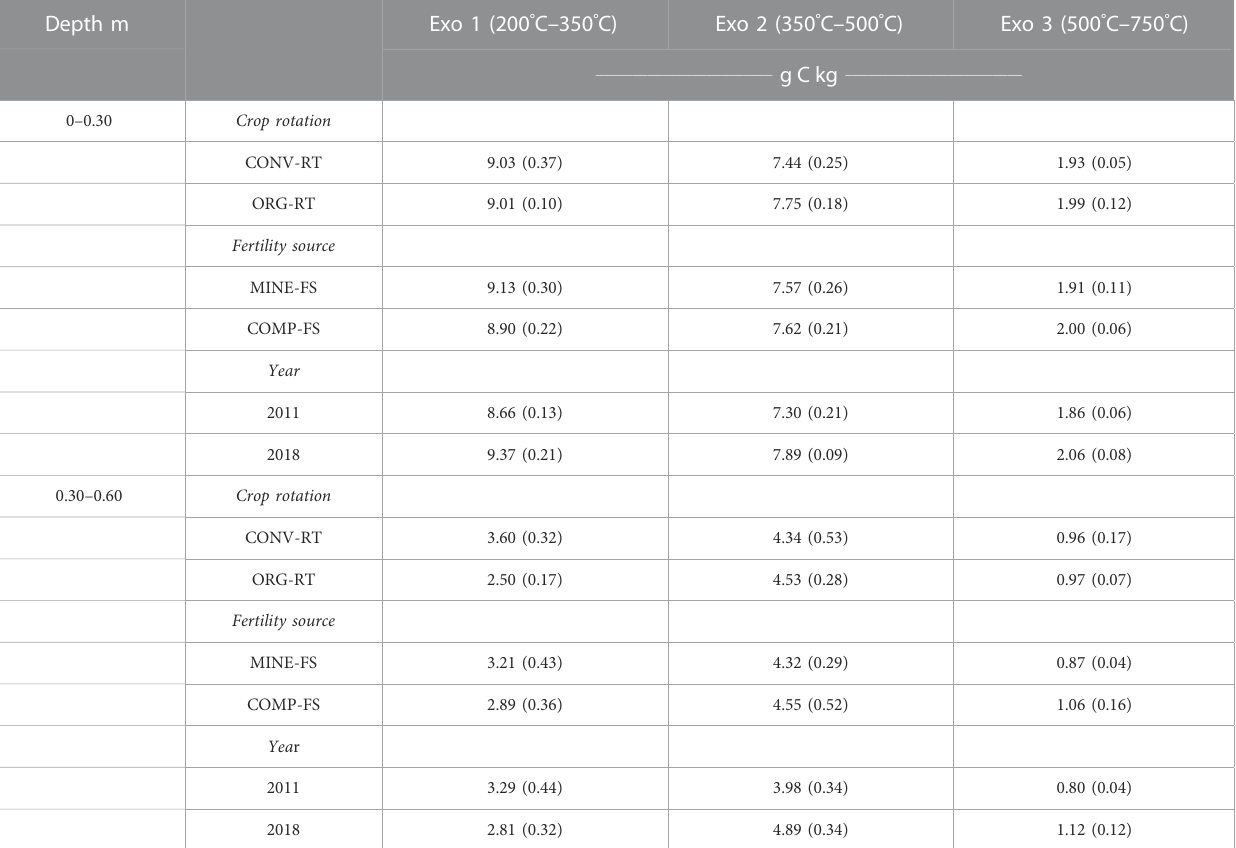
TABLE 5 Changes in carbon (C) released calculated from the m/z 44 (CO 2 ) peak areas in the temperature intervals 200 ° C – 350 ° C (Exo 1), 350 ° C – 500 ° C (Exo 2) and 500 ° C – 750 ° C(Exo3)asaresultofdifferent croprotation(conventional-CONV-RT or organic-ORG-RT),fertilitysources(mineral-MINE-FS or compost-COMP-FS) and years of sampling (YR) (2011 and